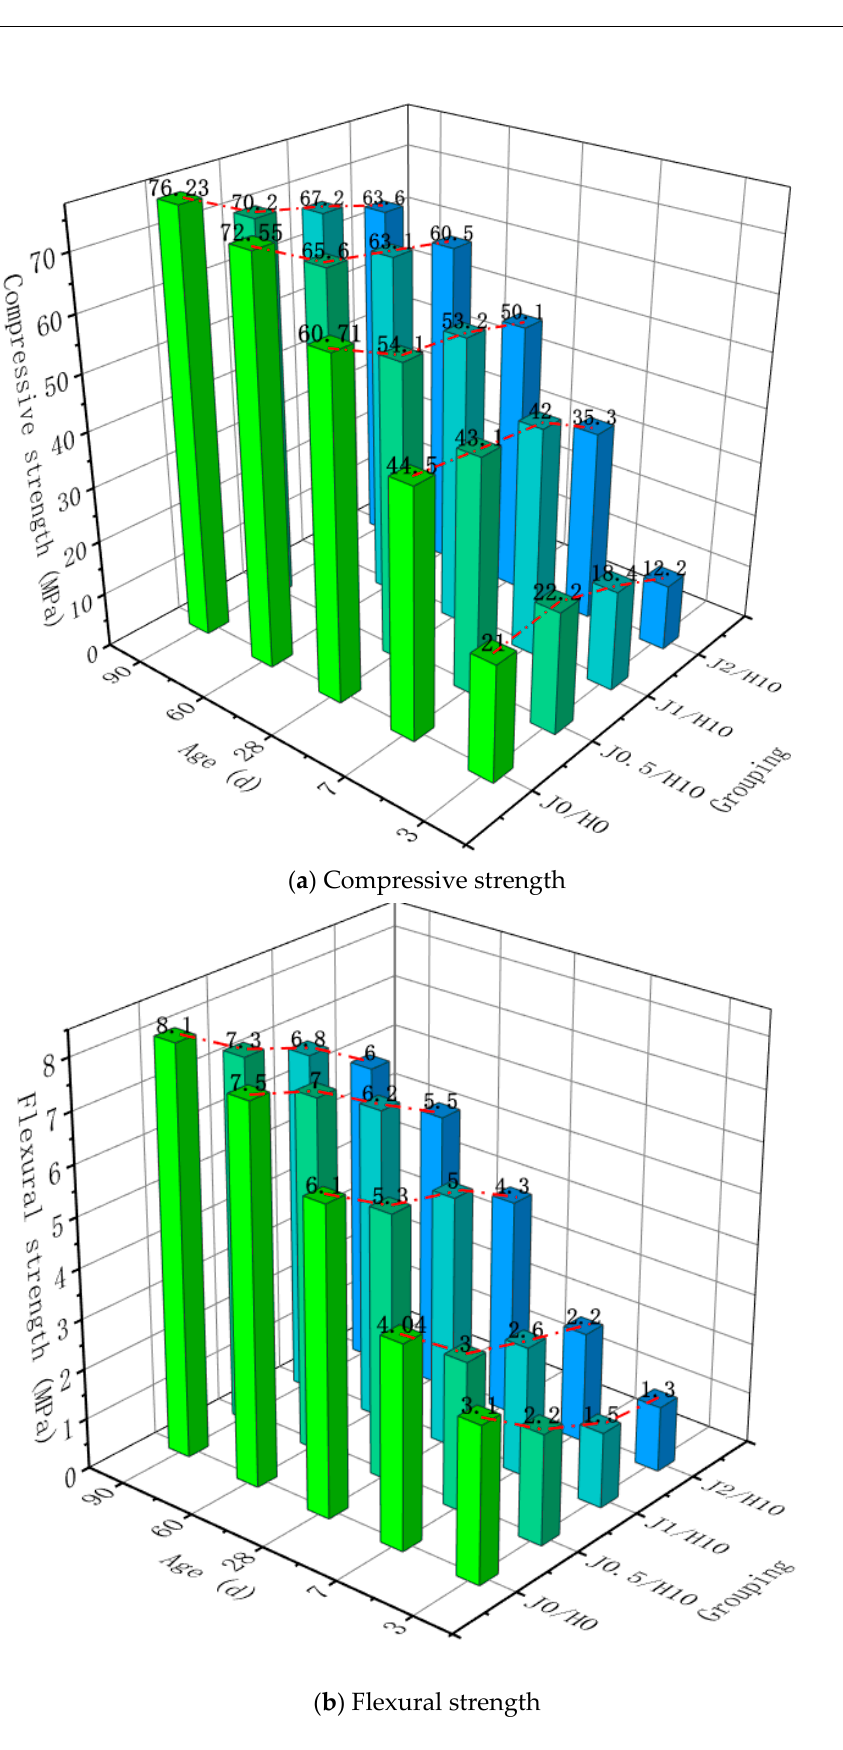
Figure 4. Effect of HPEA and shrinkage-reducing agent on the compressive strength and flexural strength of